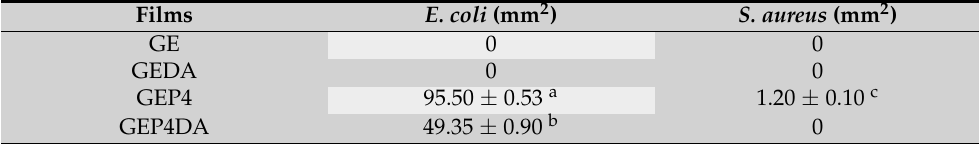
49.35 ± 0.90 b 0 a–c : Mean values ± standard deviations ( n = 9) followed by different letters within the same column are signifi- cantly different ( p <